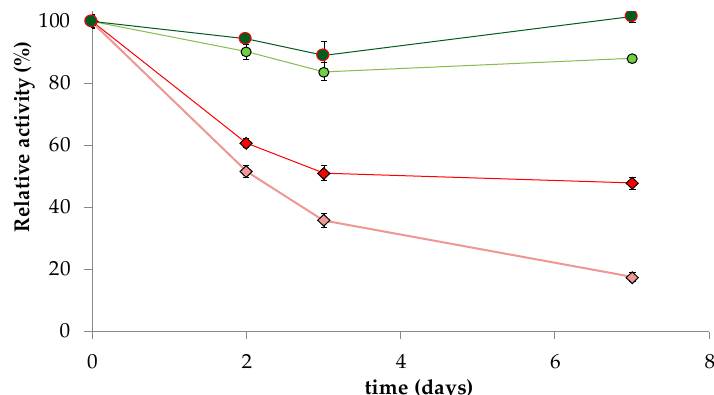
Figure 2. Effect of 20 µM Cu 2+ (dark green and red) and 200 µM Cu 2+ (light green and pink) incubations at pH 7.50 and 30 °C in presence of 0.1% ( w / v ) Triton X-100 on the relative hydrolytic activity of CNBr derivatives of cc BTL2 (circles) and BTL2 (rhombus). Initial derivative activity was 5 IU ( p -NPB) and 0.013 mg of protein/g.